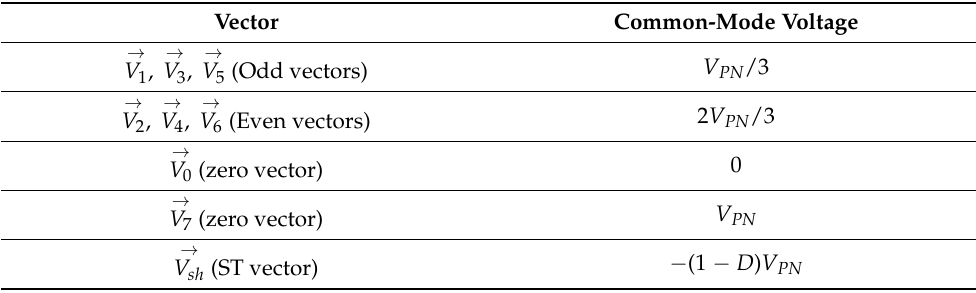
Table 1. CMV values for all vectors of AqZSI using conventional SVM method.